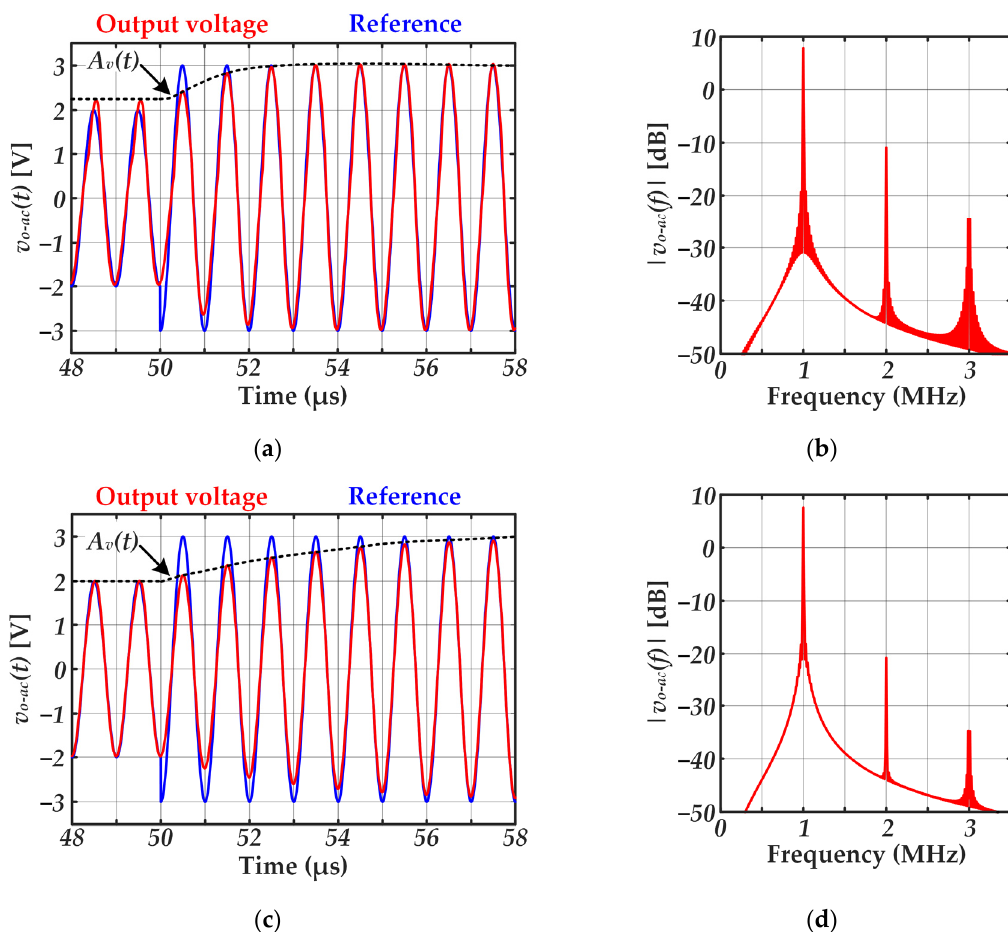
Figure 9. Response to an amplitude step from 2 V to 3 V at t = 50 µ s considering different Q values. Note that for this example, f 0 is 1 MHz and V g − 1 is 5 V. In order to track the step of the reference amplitude, a duty cycle step from 0.215 to 0.39 is performed at t = 50 µ s. ( a ) Time domain results for Q = 3. ( b ) Frequency domain results for Q = 3. ( c ) Time domain results for Q = 10. ( d ) Frequency domain results for Q =